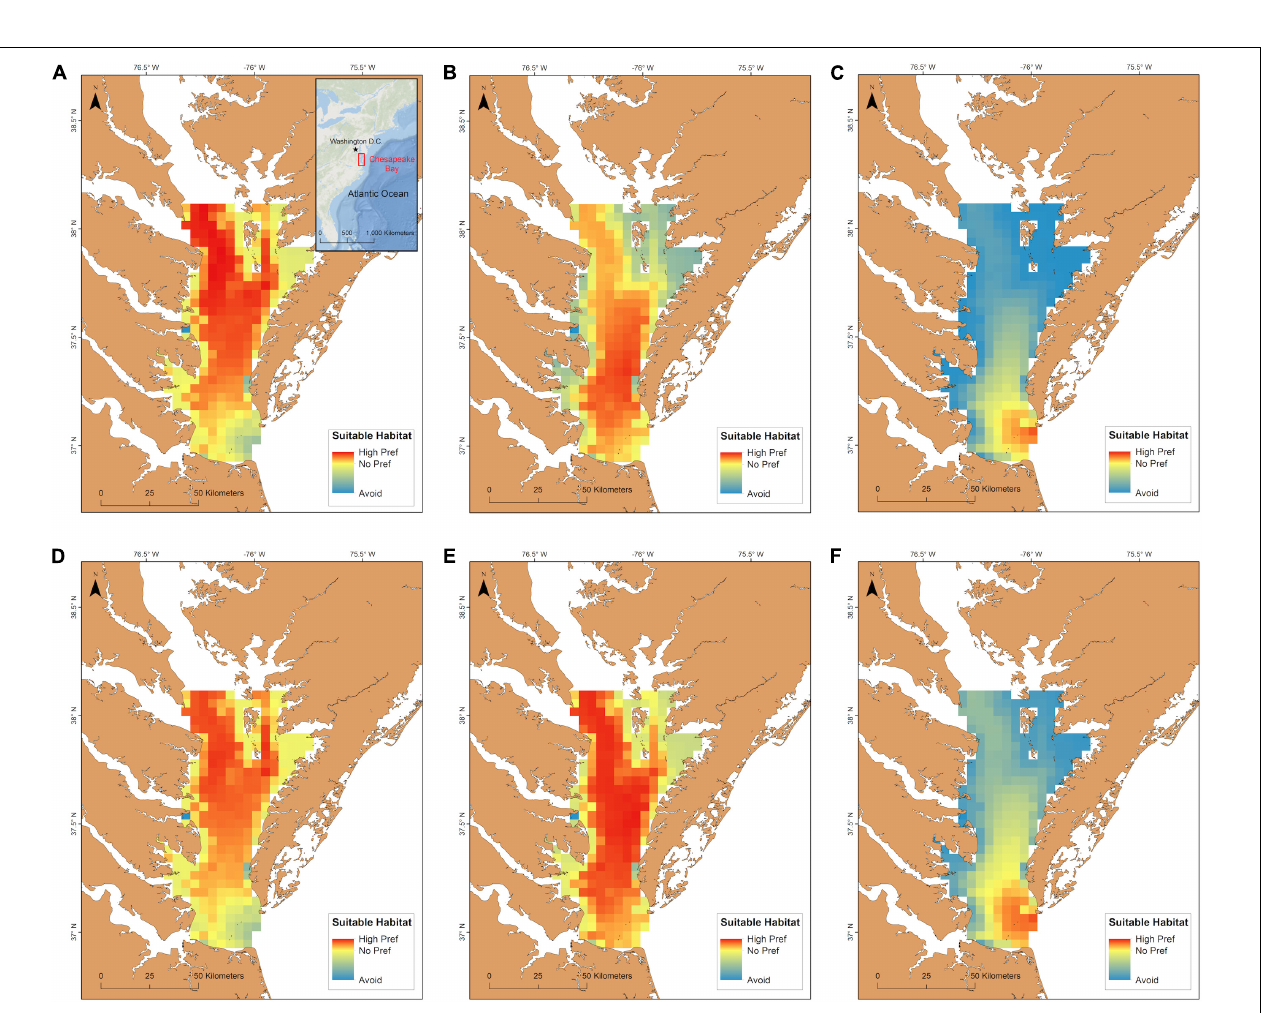
FIGURE 6 | Cobia habitat suitability within Chesapeake Bay averaged over years for the contemporary (A,D) , mid-century (B,E) , and end-of-century (C,F) time periods. The first row is mean habitat suitability for June-August (a-c) and the second row is mean habitat suitability for May 15–September 30 (D–F) .